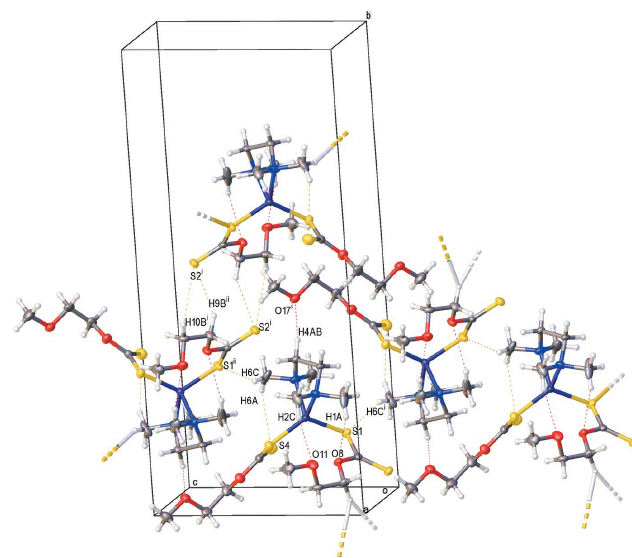
Figure 2 A view of the crystal packing of the title complex. Dashed lines denote the intermolecular hydrogen bonds (Table 2). Symmetry codes: (i) x (cid:5) 1 (cid:5) y +